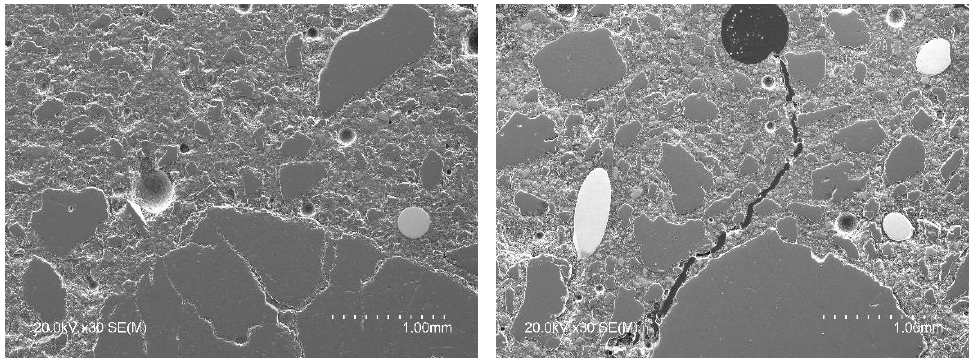
Figure 13. Recycled steel fiber (elements with spherical or elliptical shape in in light gray color) in the cementitious matrix.